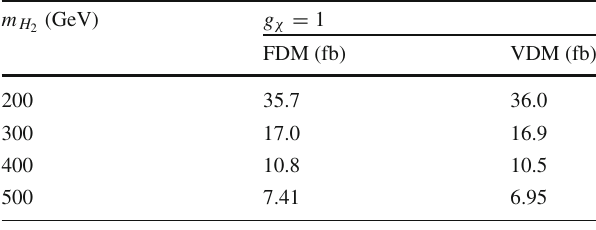
Table3 Theproductioncrosssectionsforbenchmarkpointswith g χ = 1. The branching ratio of leptonic top quark decay ( t → be ν/ b μν ) has